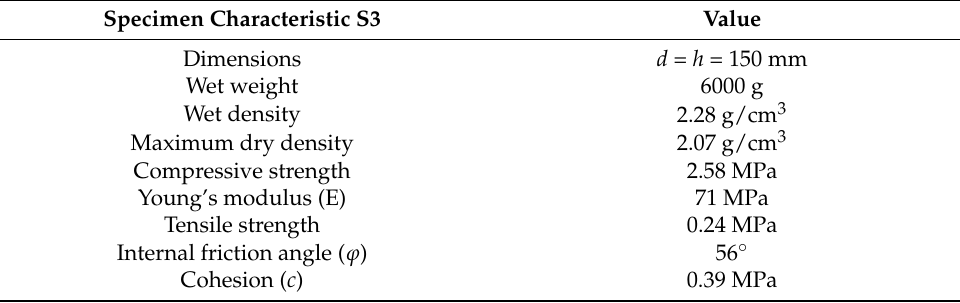
Table 6. Average characteristic parameters of the analyzed S3 specimen.